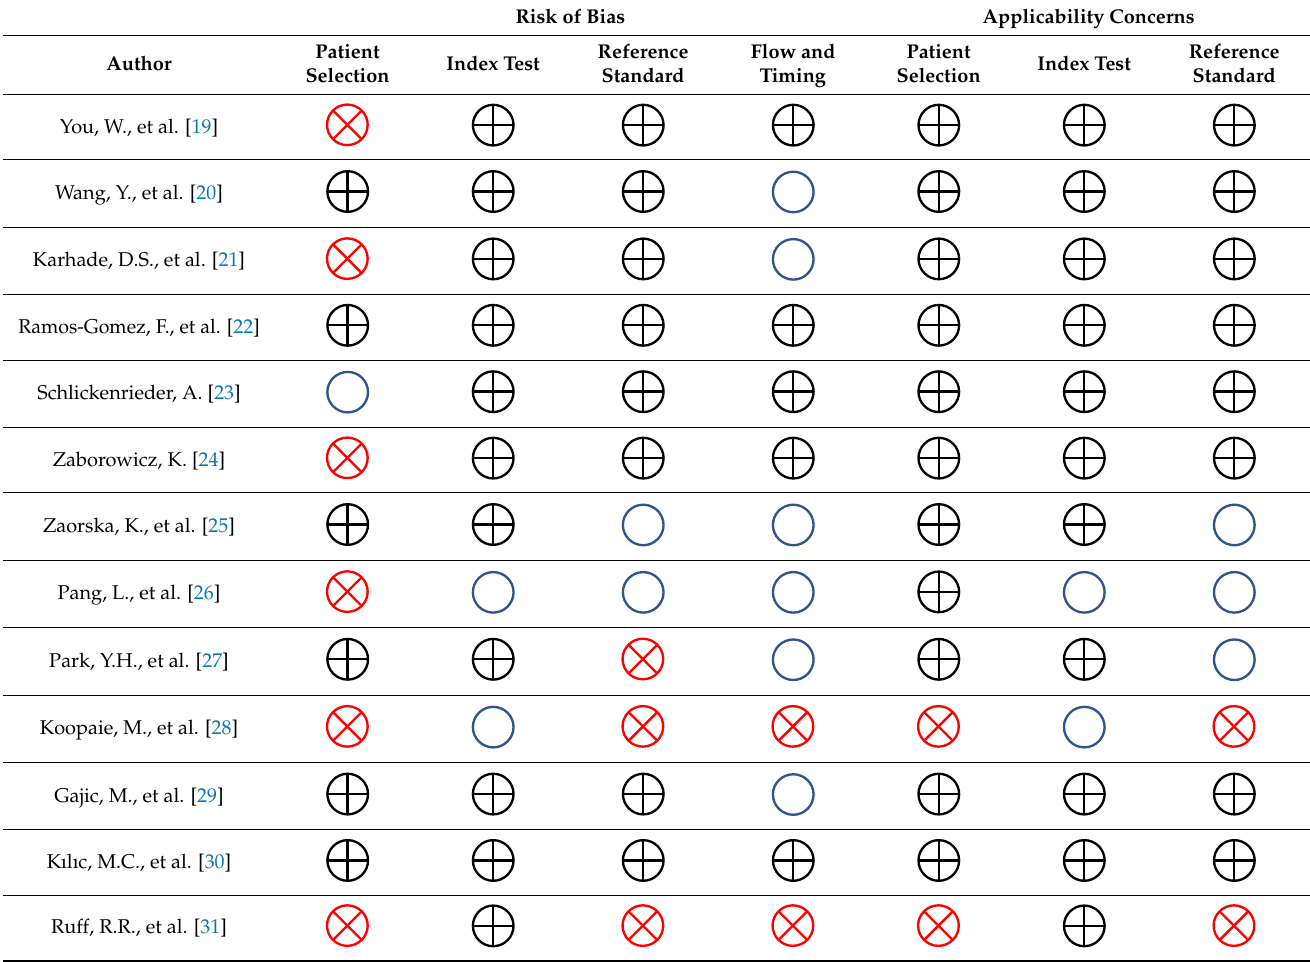
Table A1. S tructured search strategy carried out in electronic databases. Table A2. Assessment of risk of bias domains and applicability concerns.